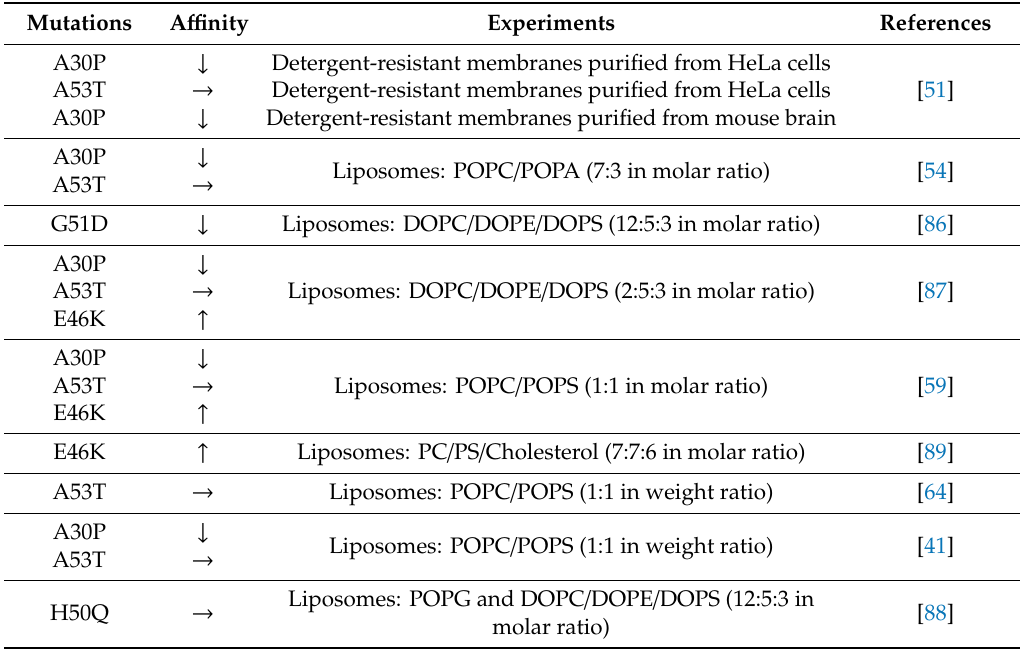
Abbreviations: POPA, 1-palmitoyl 2-oleoyl- sn -glycero-3-phosphatidic acid; POPS, 1-palmitoyl-2-oleoyl- sn -glycero-3-phosphoserine; POPC, 1-palmitoyl-2-oleoyl- sn -glycero-3-phosphocholine; POPG, 1-hexadecanoyl-2- octadecenoyl- sn -glycero-3- phosphatidylglycerol; DOPS, 1,2-dioleoyl- sn -glycero-3-phosphoserine; DOPE, 1,2-dioleoyl- sn -glycero-3-phosphoethanolamine; DOPC, 1,2-dioleoyl- sn -glycero-3-phosphocholine. ↑ , increased; ↓ , decreased; → ,